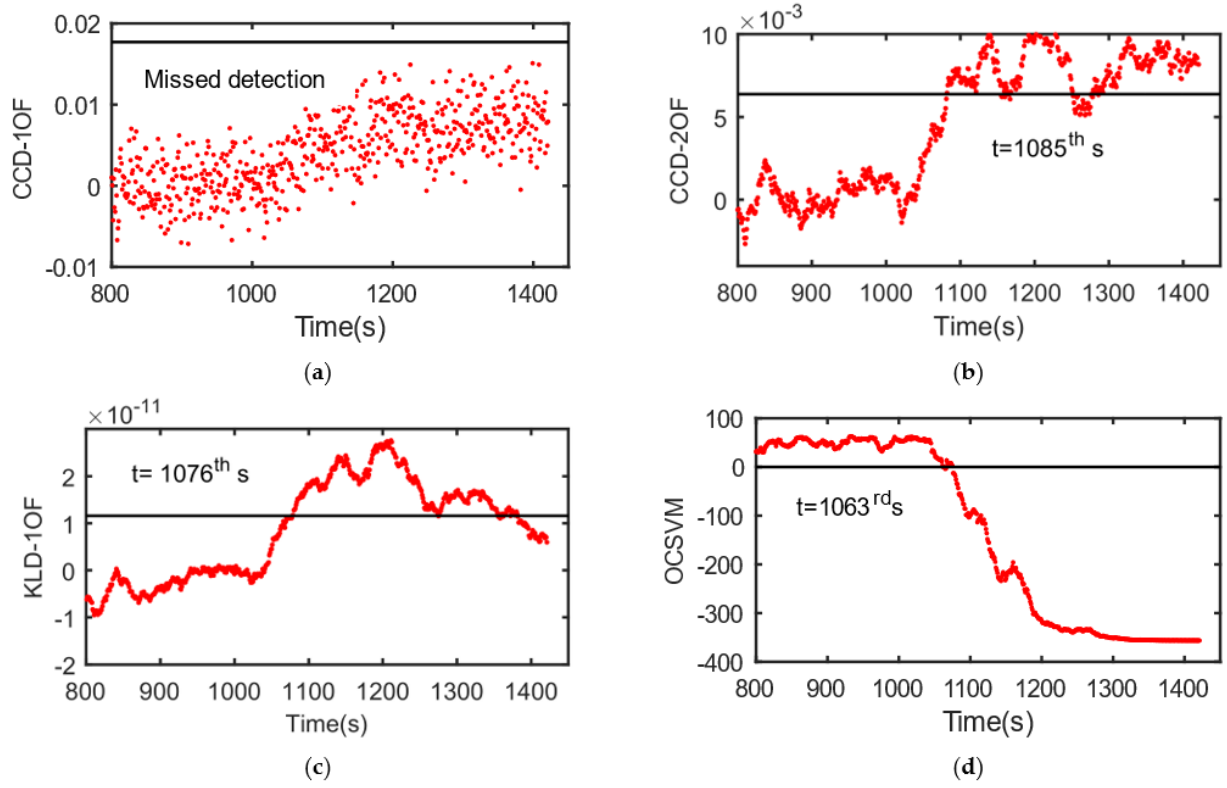
Figure 18. Variation of the test statistics and thresholds of the CCD-1OF ( a ), CCD-2OF ( b ), KLD-1OF ( c ) and the proposed OCSVM-based ( d ) monitors in the presence of an real ionospheric anomaly event. If the ionospheric anomaly is successfully detected, the detection time is included. Note that the ionospheric anomaly starts at the 1000th epoch.